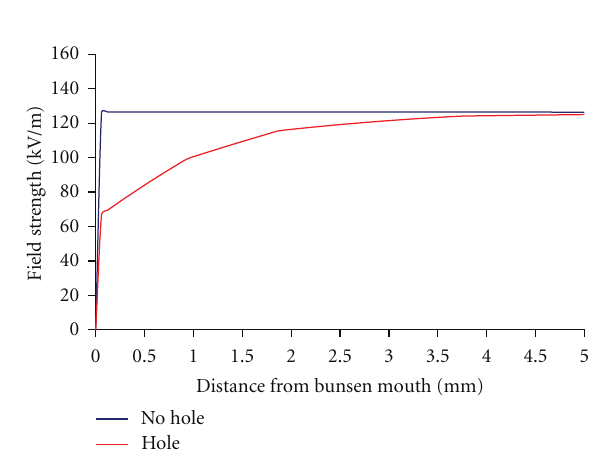
Figure 17: Enlargement of Figure